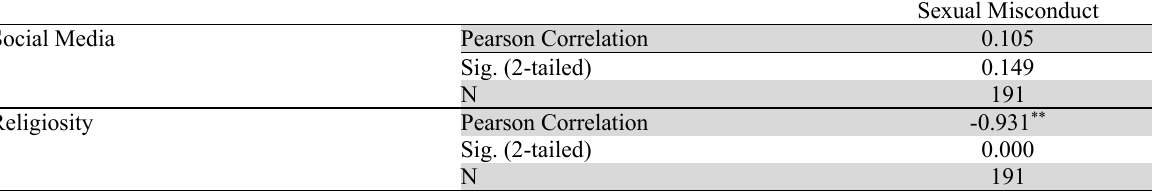
Correlations between Social Media and Religiosity